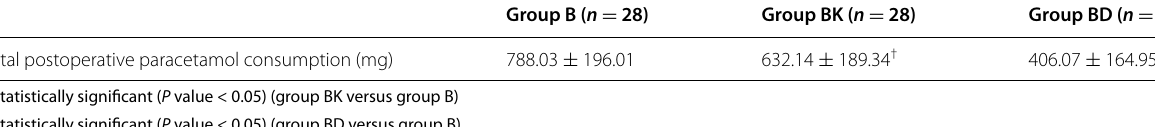
Table 7 The time to 1st postoperative rescue analgesia (mean Time recorded The time to 1st postoperative analgesic (hours) † Statistically significant ( P value < 0.05) (group BK versus group B) ‡ Statistically significant ( P value < 0.05) (group BD versus group B) # Statistically significant ( P value < 0.05) (group BD versus group BK) Table 8 Total postoperative paracetamol consumption in the study groups (mean